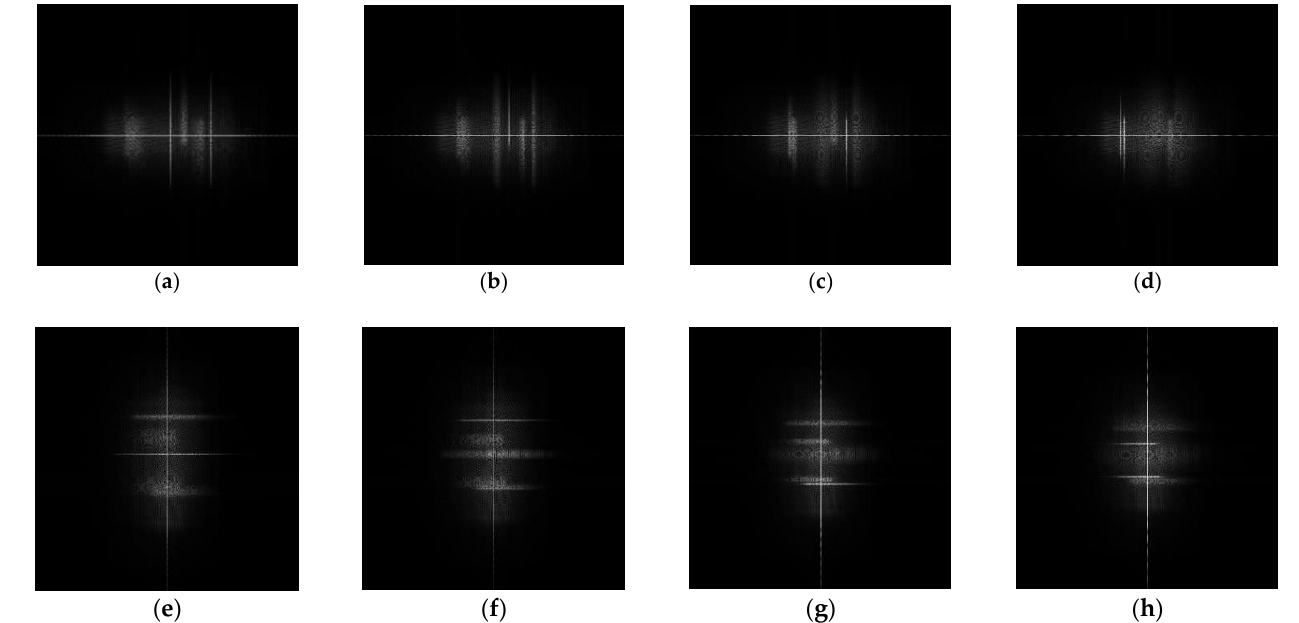
Figure 4. The fractional Fourier spectra of the mixed signals in Figure 3a with the various fractional orders: ( a ) α = (0.73,1); ( b ) α = (0.76,1); ( c ) α = (0.79,1); ( d ) α = (0.82,1); ( e ) α = (1,0.73); ( f ) α = (1,0.76); ( g ) α = (1,0.79); ( h ) α = (1,0.82). Appl. Sci. 2021 , 11 , x FOR PEER REVIEW